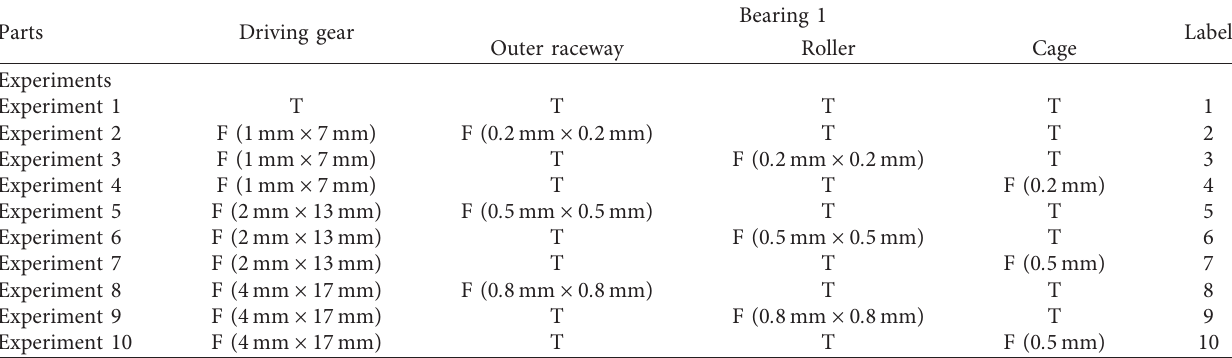
Table 6: Experiment